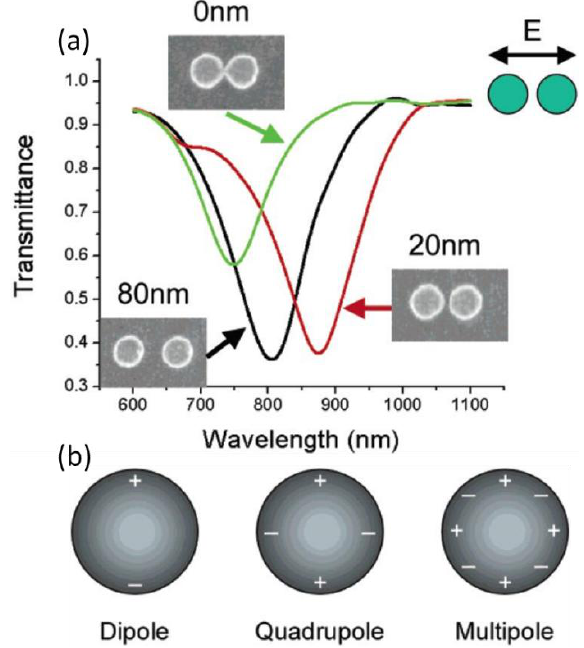
Figure 15. ( a ) Polarized transmission spectra in periodic arrays of pairwise interacting gold nanoparticles. The lattice constant is 800 nm in parallel direction to the pair axis, 400 nm perpendicular, and the dot height is 30 nm; ( b ) pictorial illustration of charge distributions for dipole, quadrupole, and multipole modes for a single spherical particle [99]. Reprinted with permission from Ref. [99].